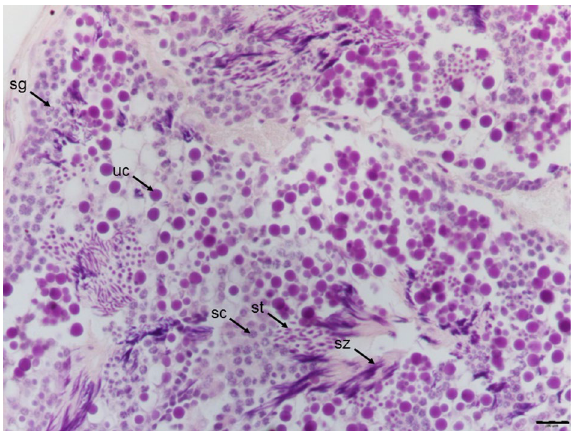
Figure 6. Reproductive cells in a testis of Thais clavigera : spermatogonium (sg), spermatocyte (sc), spermatid (st), and spermatozoon (sz). Unidentified cells (uc) that were almost the same size as spermatocytes